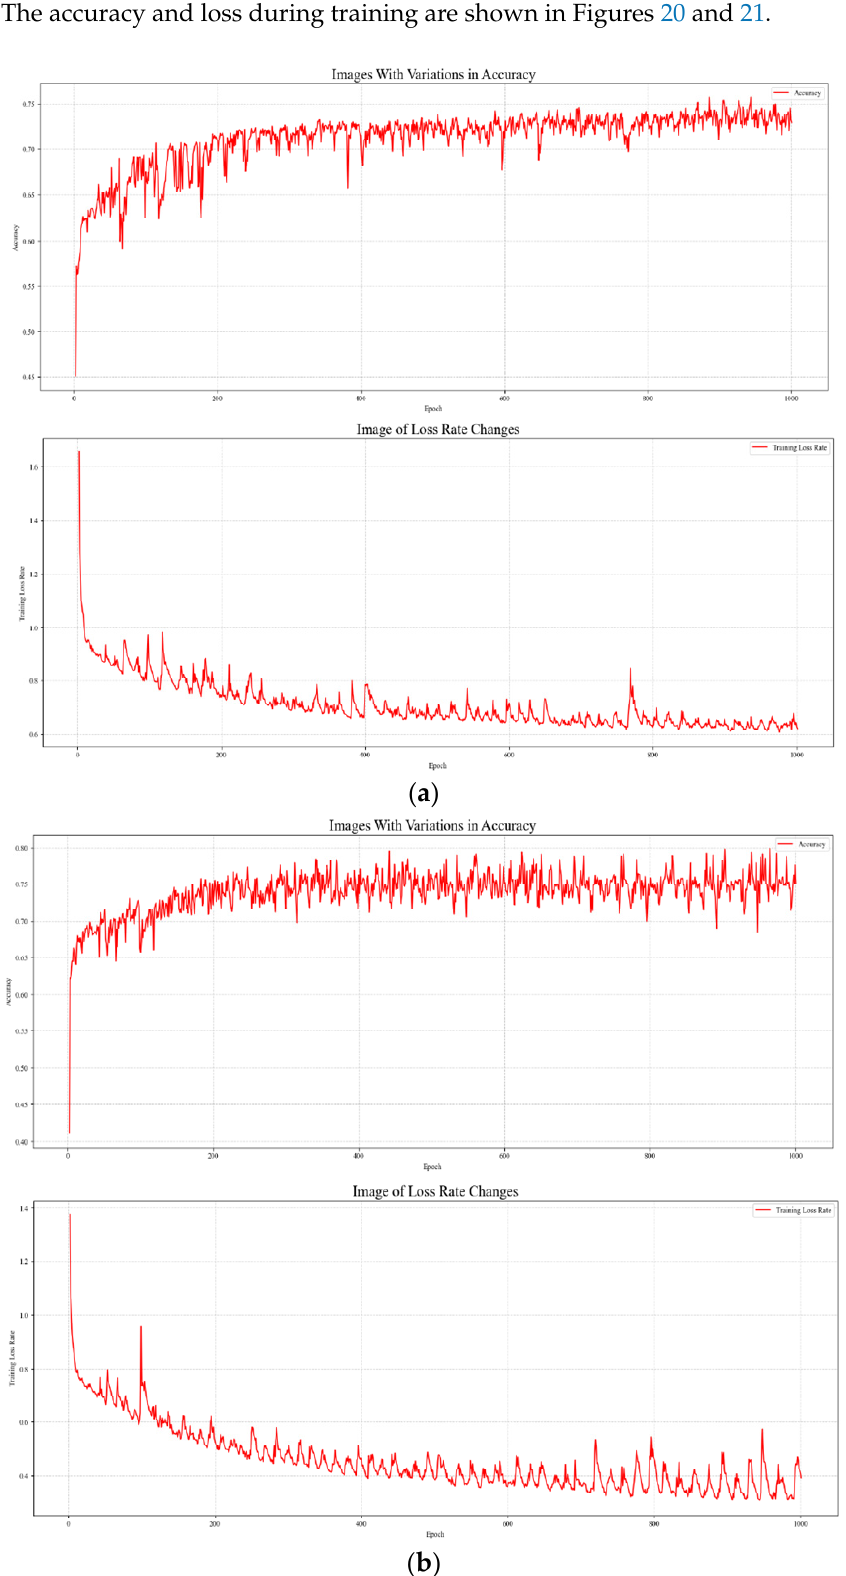
Figure 20. ( a ) Training accuracy and loss change of IMU. ( b ) Training accuracy and loss change of RATE.